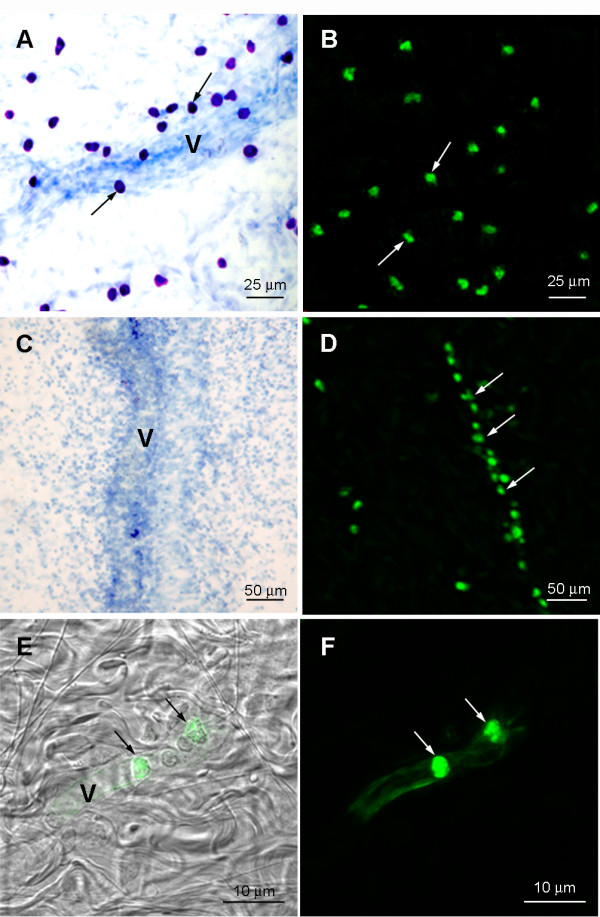
Mast cell progenitors are present in mesenteric blood vessels 48 hours after IP injection of distilled water . (A) In animals not injected with distilled water, mast cells (arrows) can be seen along a blood vessel (V) and in the mesenteric windows. (B) The mast cells (arrows) are positive when immunolabeled with mAb AA4-FITC (arrows). (C) No mast cells are seen in the mesentery or along a mesenteric blood vessel (V) 48 hours after distilled water injection. Toluidine blue. (D) MCp (arrows), detected by mAb AA4-FITC, are associated with and inside blood vessels (arrows). (E) Superimposition of MCp in a blood vessel immunolabeled with mAb AA4-FITC (arrows) seen in F with corresponding DIC image. Other blood cells, which do not label with mAbAA4, are also present inside the blood vessel. (F) At this magnification, MCp labelled with mAb AA4-FITC are clearly seen inside a mesenteric blood vessel.